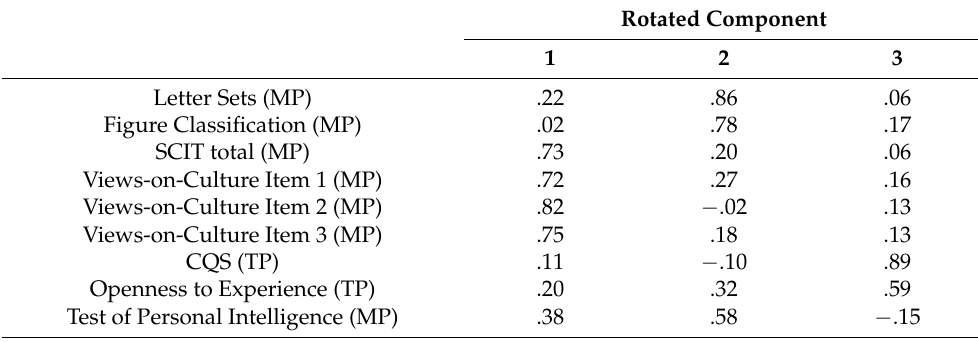
Extraction method: Principal Component Analysis.